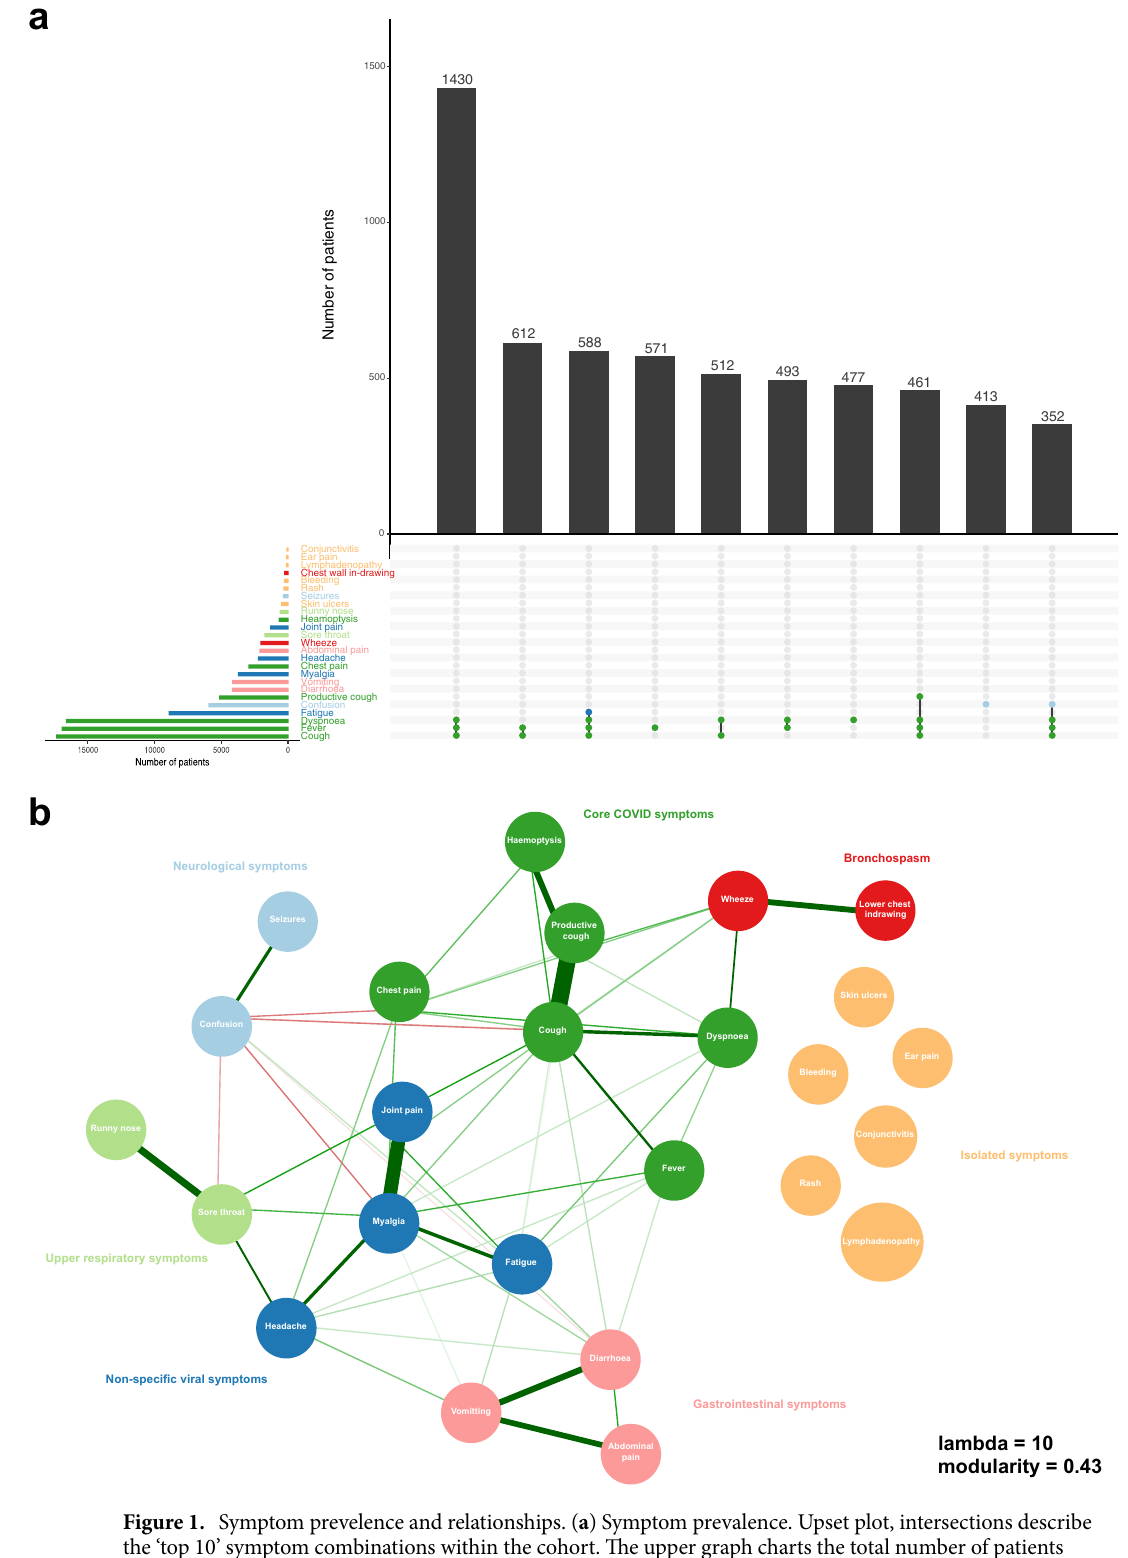
Figure 1. Symptom prevelence and relationships. ( a ) Symptom prevalence. Upset plot, intersections describe the ‘top 10’ symptom combinations within the cohort. The upper graph charts the total number of patients exhibiting these symptom sets. The lower graph charts the total number of patients with each symptom in the cohort. ( b ) Symptom network graph, derived using eLasso. Lines between symptom nodes illustrate conditional dependencies. A thicker line width and darker hue represents a stronger positive conditional dependence. Red lines represent a negative conditional